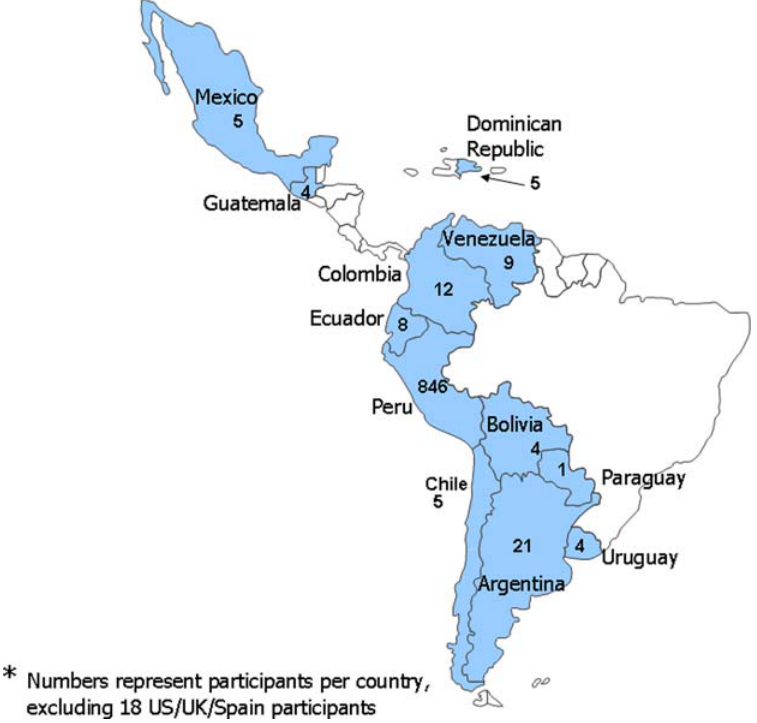
Figure 2. Courses and participants, 2004–2007.